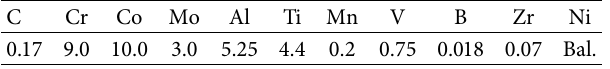
Table 1: Nominal composition of the K417G superalloy